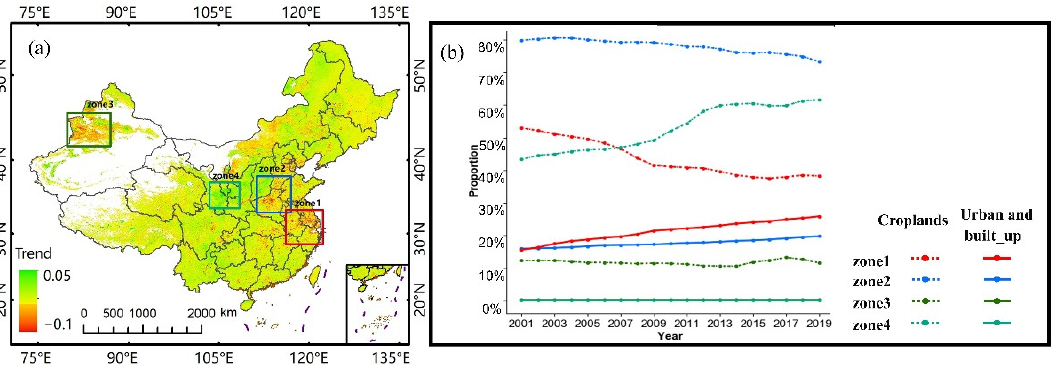
Figure 11. ( a ) Spatial distribution of residual NDVI trends in China over the 1998–2019 period; ( b ) variation of human-dominated land cover (croplands and urban/built-up) in percentage in four typical zones over the 2001–2019 period.